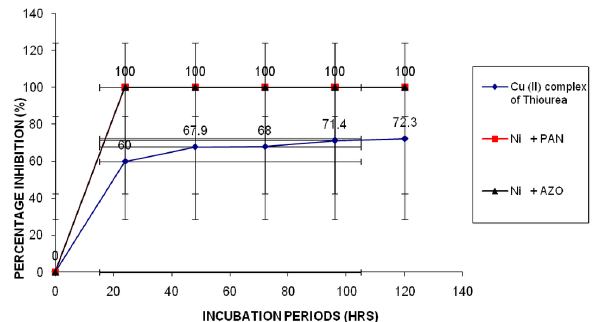
Fig. 1. Reduction of Mycelial growth of Geotrichum candidum at 10 mg/ml